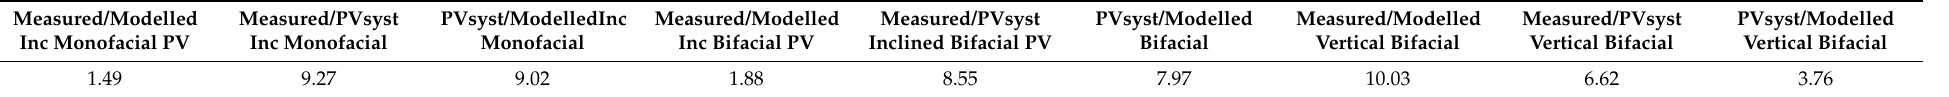
Table 6. Root mean square error of monthly potential energy